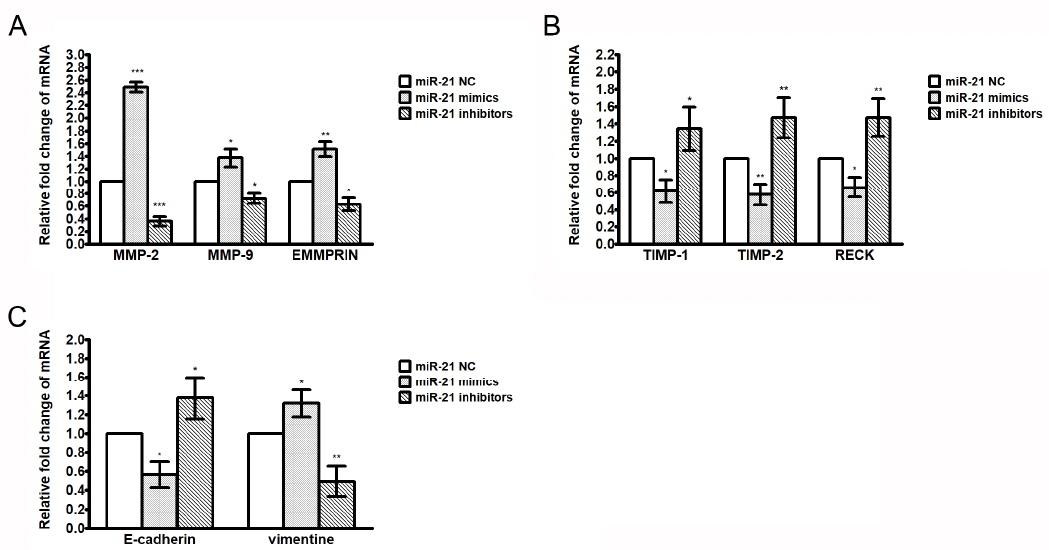
Figure 6. E ff ect of miR-21 on the expressions of MMP-2 / -9, EMMPRIN / CD147, TIMP-1 / -2, RECK, E-cadherin, and vimentin in A549 cells. A549 cells were transfected with the miR-21 negative control, miR-21 mimics, or mir-21 inhibitors for 48 hrs. Cells were harvested and the expressions of MMP-2, MMP-9, and EMMPRIN / CD147 mRNA ( A ), TIMP-1, TIMP-2, and RECK ( B ), and E-cadherin and vimentin ( C ) were analyzed by quantitative real-time PCR. Data are expressed as mean ± S.D. of three independent experiments. * p < 0.05, ** p < 0.01, *** p < 0.001 compared with the untreated control.